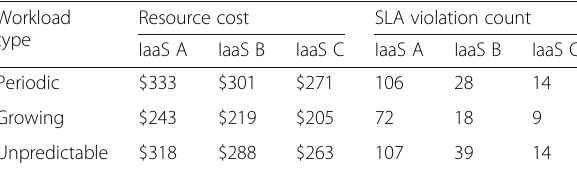
Table 3 The cost factor values for the different VM boot-up times (iteration 2 – with database tier )